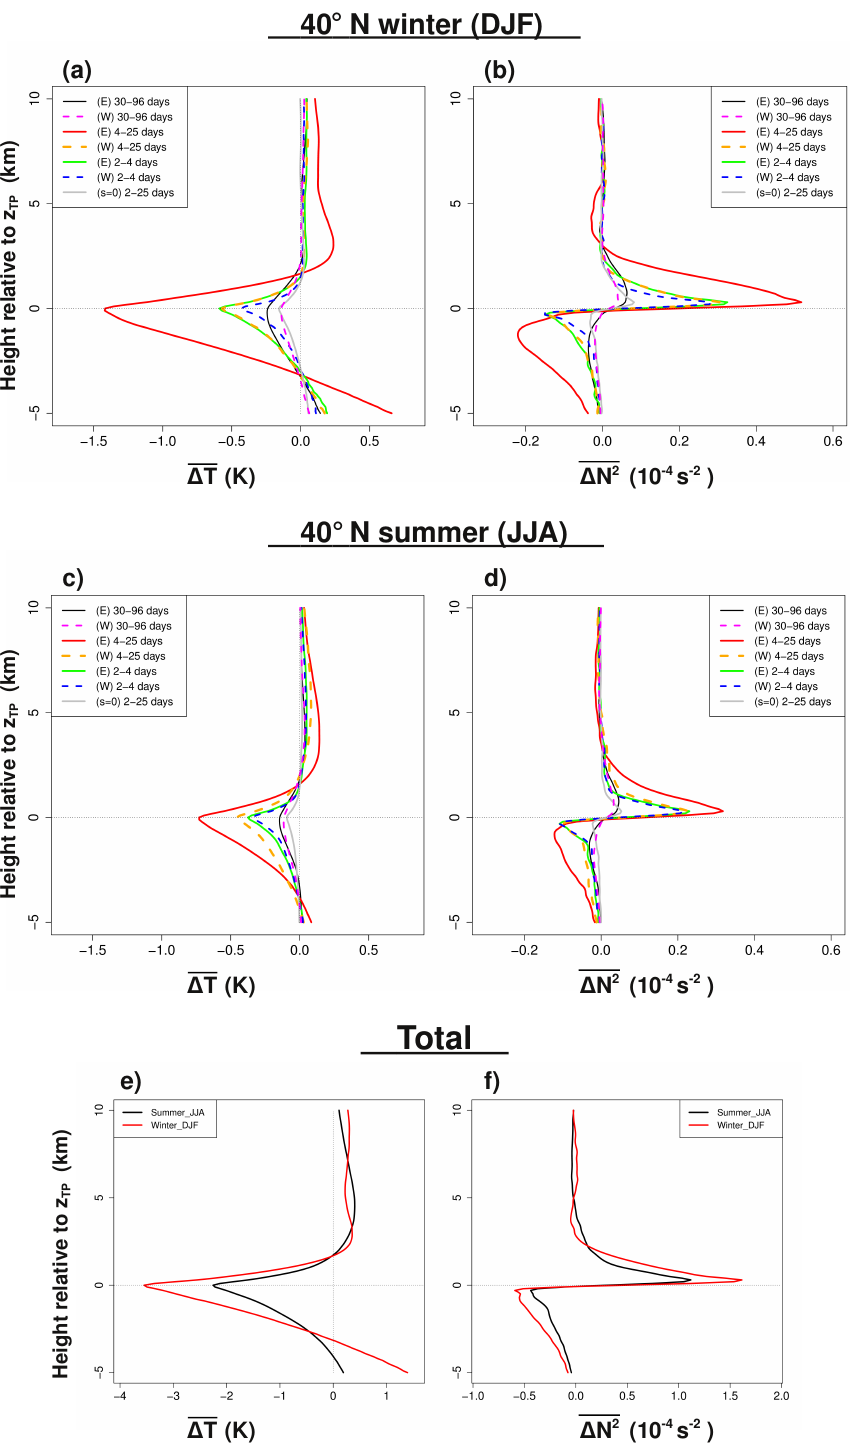
Figure 4. Average signature of the different wave spectral regions at 40 ◦ N, as the mean anomaly in the zonal-mean vertical profiles of temperature ( (cid:49)T , left column) and static stability ( (cid:49)N 2 , right column). Top row (a, b) for winter (DJF) and middle row (c, d) for summer (JJA). Bottom row (e, f) compares the total seasonal wave